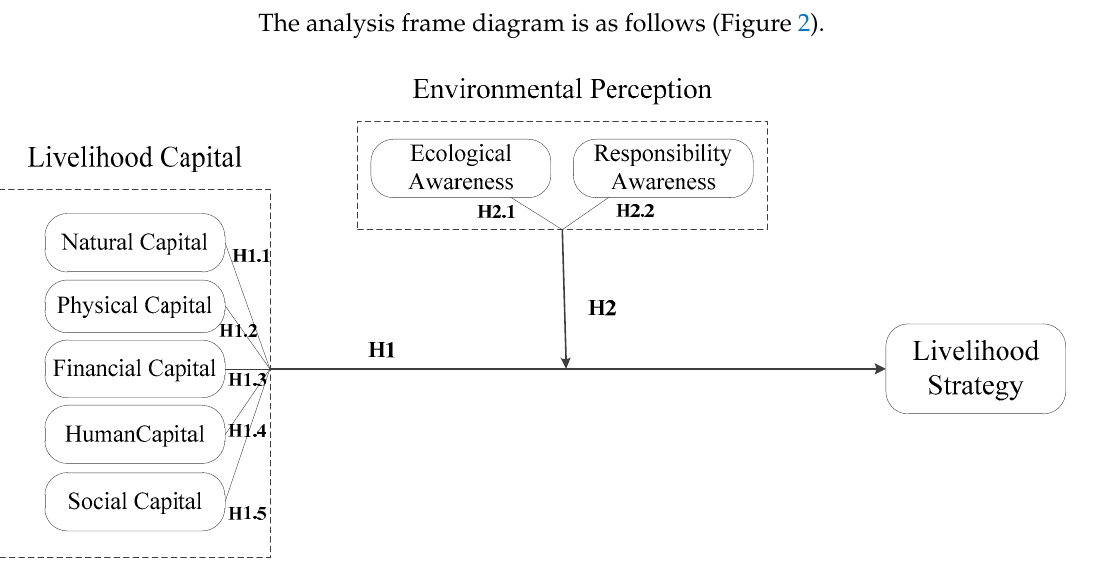
Figure 2. Analysis frame diagram.